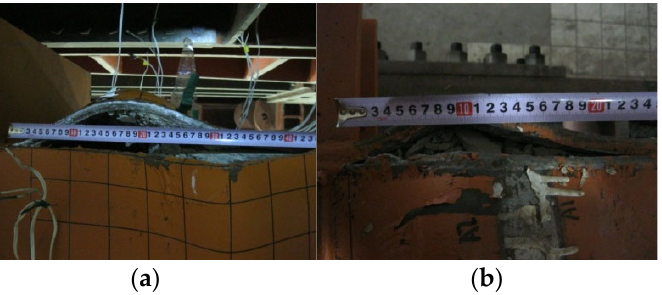
Figure 7. Tearing of the weld in the 2 ‐ cells specimens with partial penetration welds. ( a ) PEN1; ( b ) PEN3.